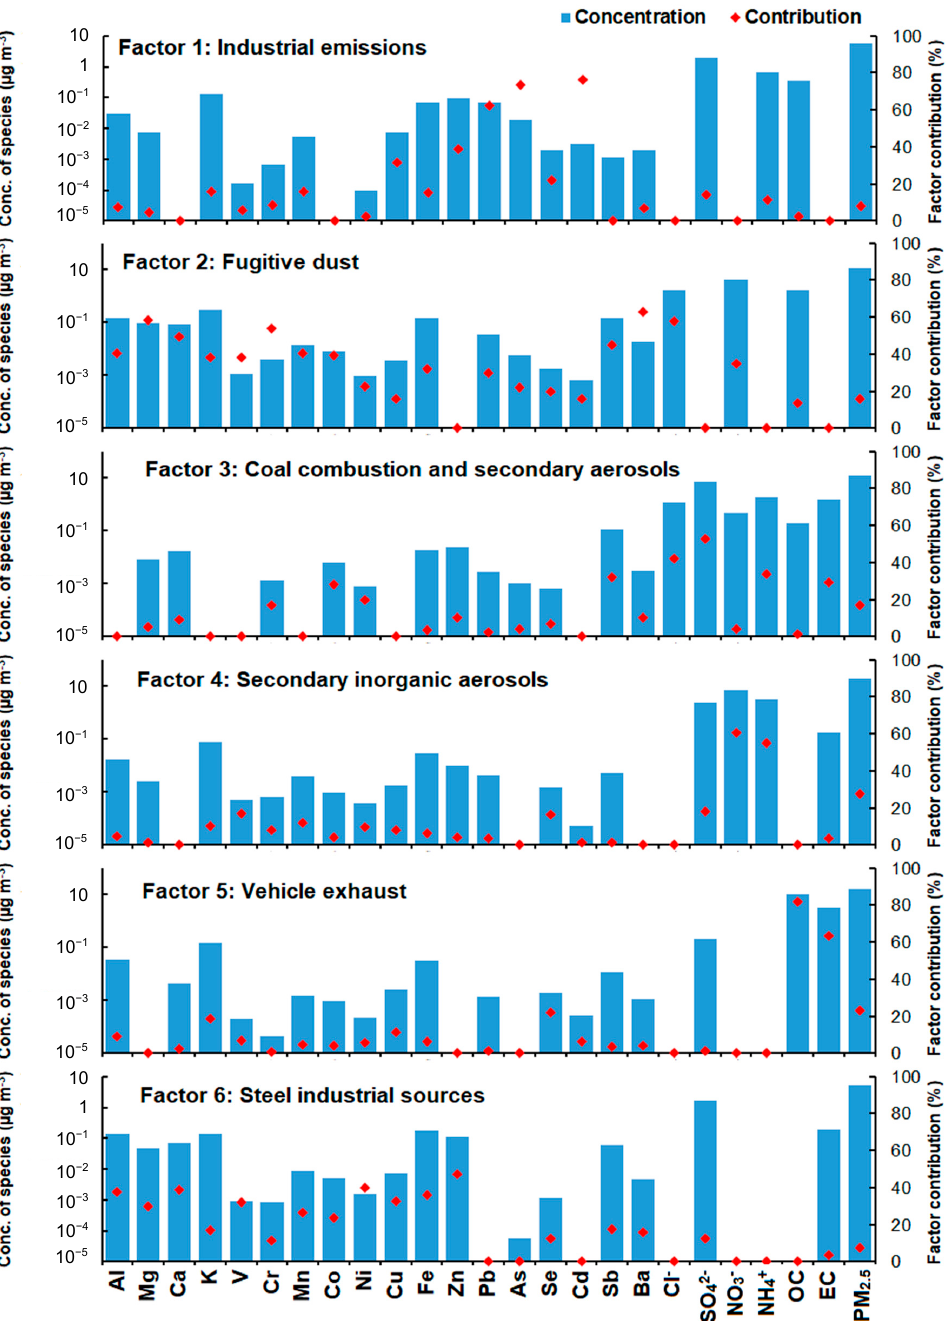
Figure 7. Factor profiles (bars and left y-axis) and percentage contributions (dots and right y-axis) of each chemical component resolved from the positive matrix factorization (PMF) model. Factor 1 to 6 represents industrial emissions, fugitive dust, coal combustion and secondary aerosols, secondary inorganic aerosols, vehicle exhaust, and steel industry.